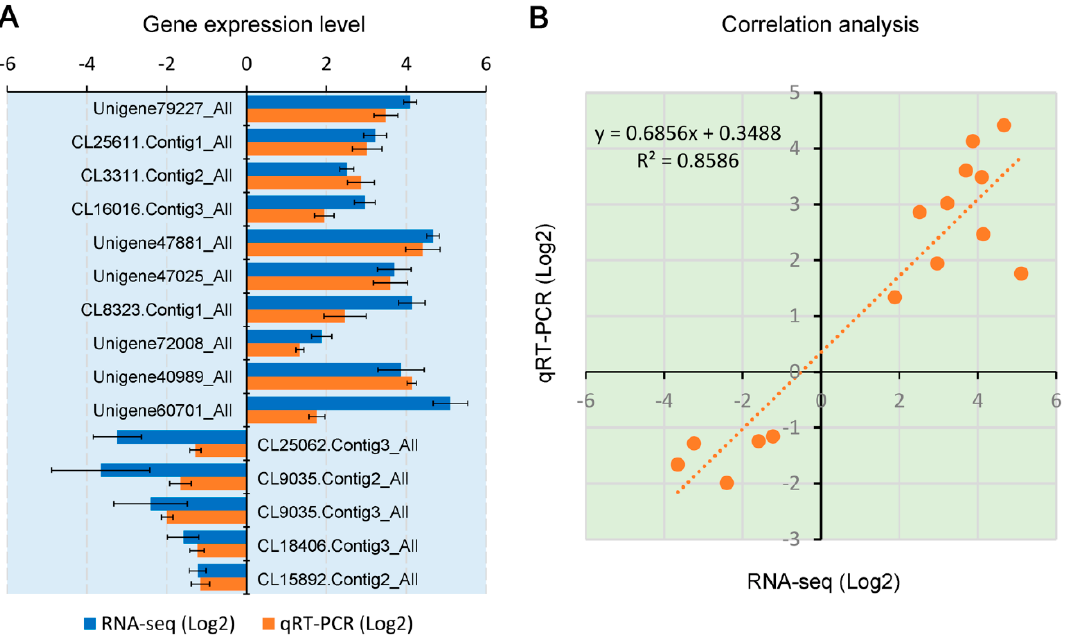
Figure 6. RT-qPCR validation and correlation analysis of gene expression levels between RNA sequencing (RNA-Seq) and RT-qPCR data. ( A ) RT-qPCR analysis of gene expression levels. Fifteen DEGs potentially responding to TYLCCNA were selected and subjected to RT-qPCR analysis using the same RNA as for RNA-Seq. NbACT2 was used as an internal reference. ( B ) Correlation of gene expression levels between RNA-Seq data and RT-qPCR analysis. Both x - and y -axes are shown in the Log2 scale.